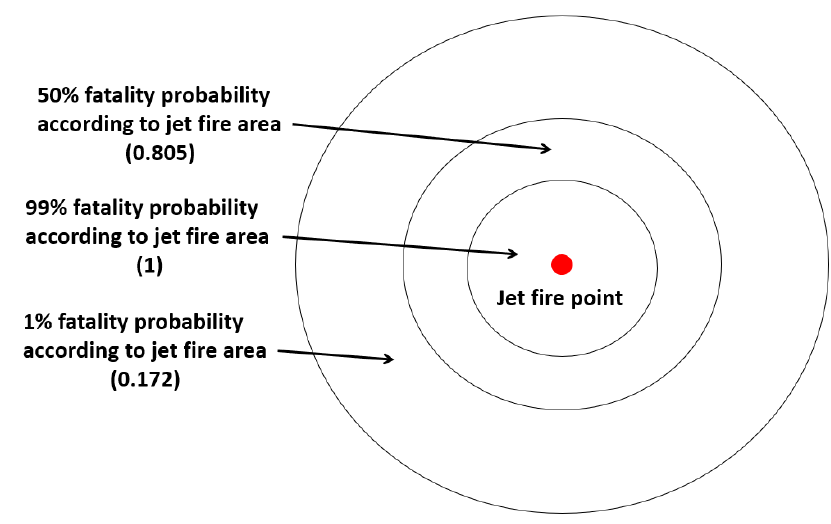
Figure 3. Schematic of fatality probability according to areas around a jet fire